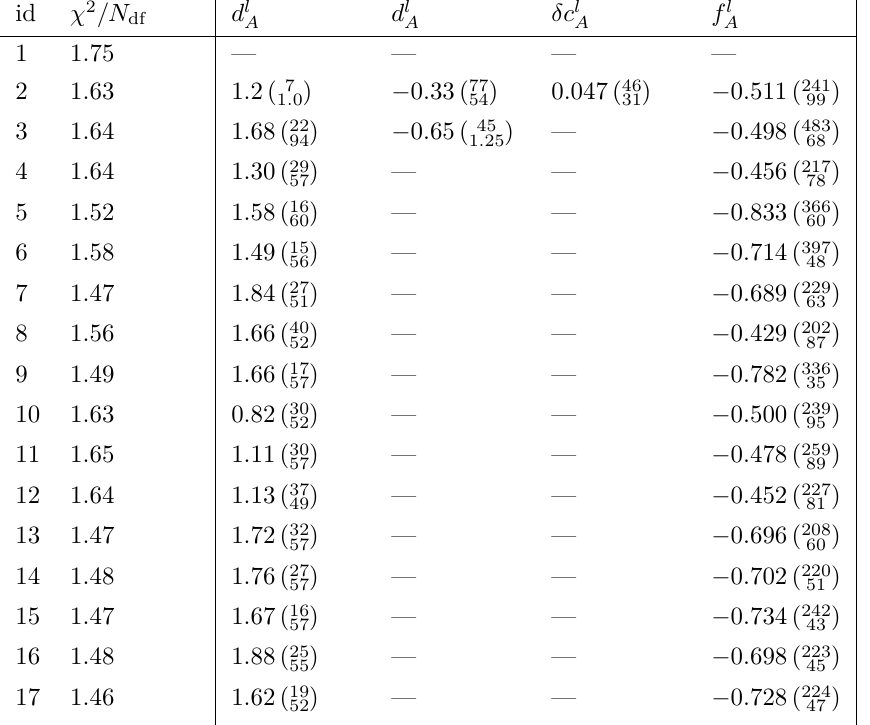
Fit results for the unknown O ( a ) improvement coefficients, see eqs. (5.50), (5.51) and (5.52). The fit ids are defined in table 7.